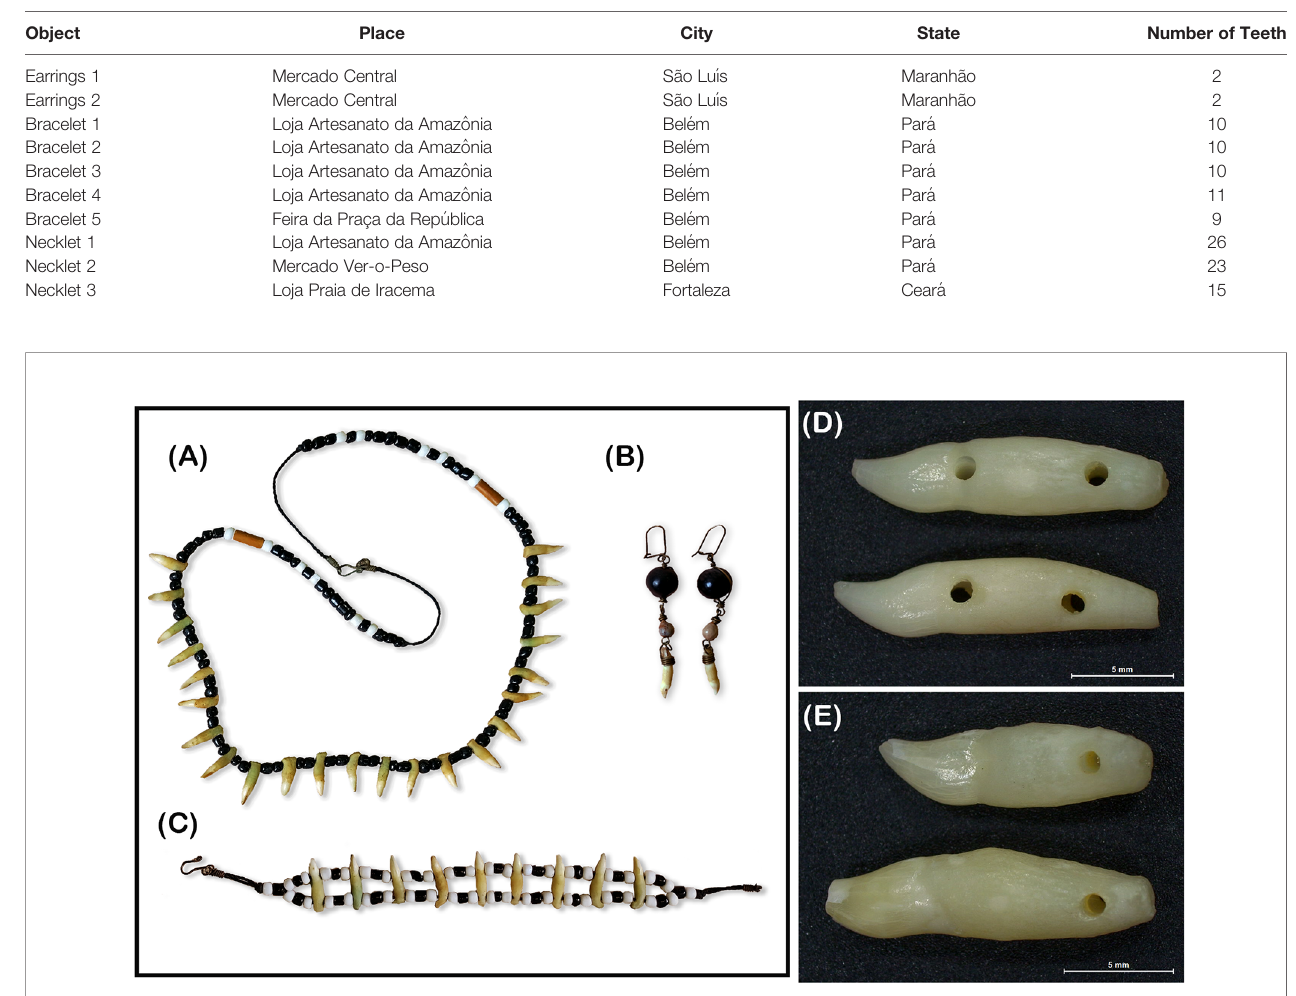
FIGURE 2 | Sample of handicrafts manufactured with teeth of Sotalia dolphins and commercialized in the trade of artisanal objects in the North-Northeastern of Brazil: (A) necklace, (B) earrings, (C) bracelet, (D) Sotalia guianensis teeth from a bracelet, (E) Two different types of Sotalia sp. teeth detected in the